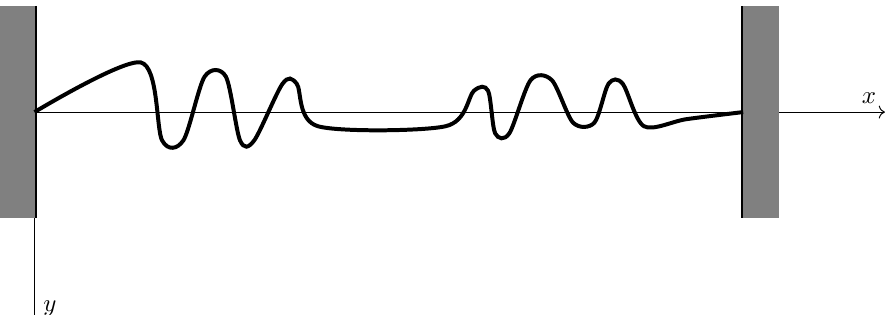
Figure 2. The converse to the Figure 1 may not be true; for example, if the maximum deflection is small, but the slope is large due to the presence of steep “ripples”, the deflection of the beam is